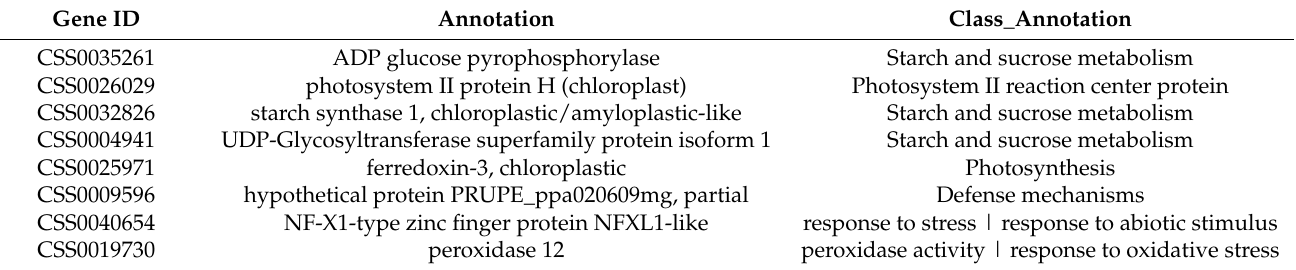
Table 4. Genes identified by weighted gene co-expression network analysis (WGCNA).